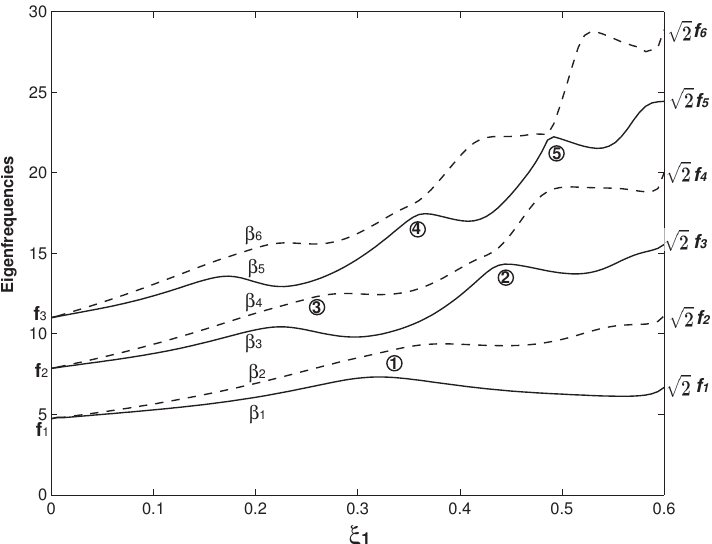
Figure 9. The impact of the overhang asymmetry on the eigenfrequencies. Compared with the dimensions in Figure 8, all the dimensions are kept the same except the overhang lengths. The asymmetric configuration of ξ 1 = 1.5 ξ 2 is set.